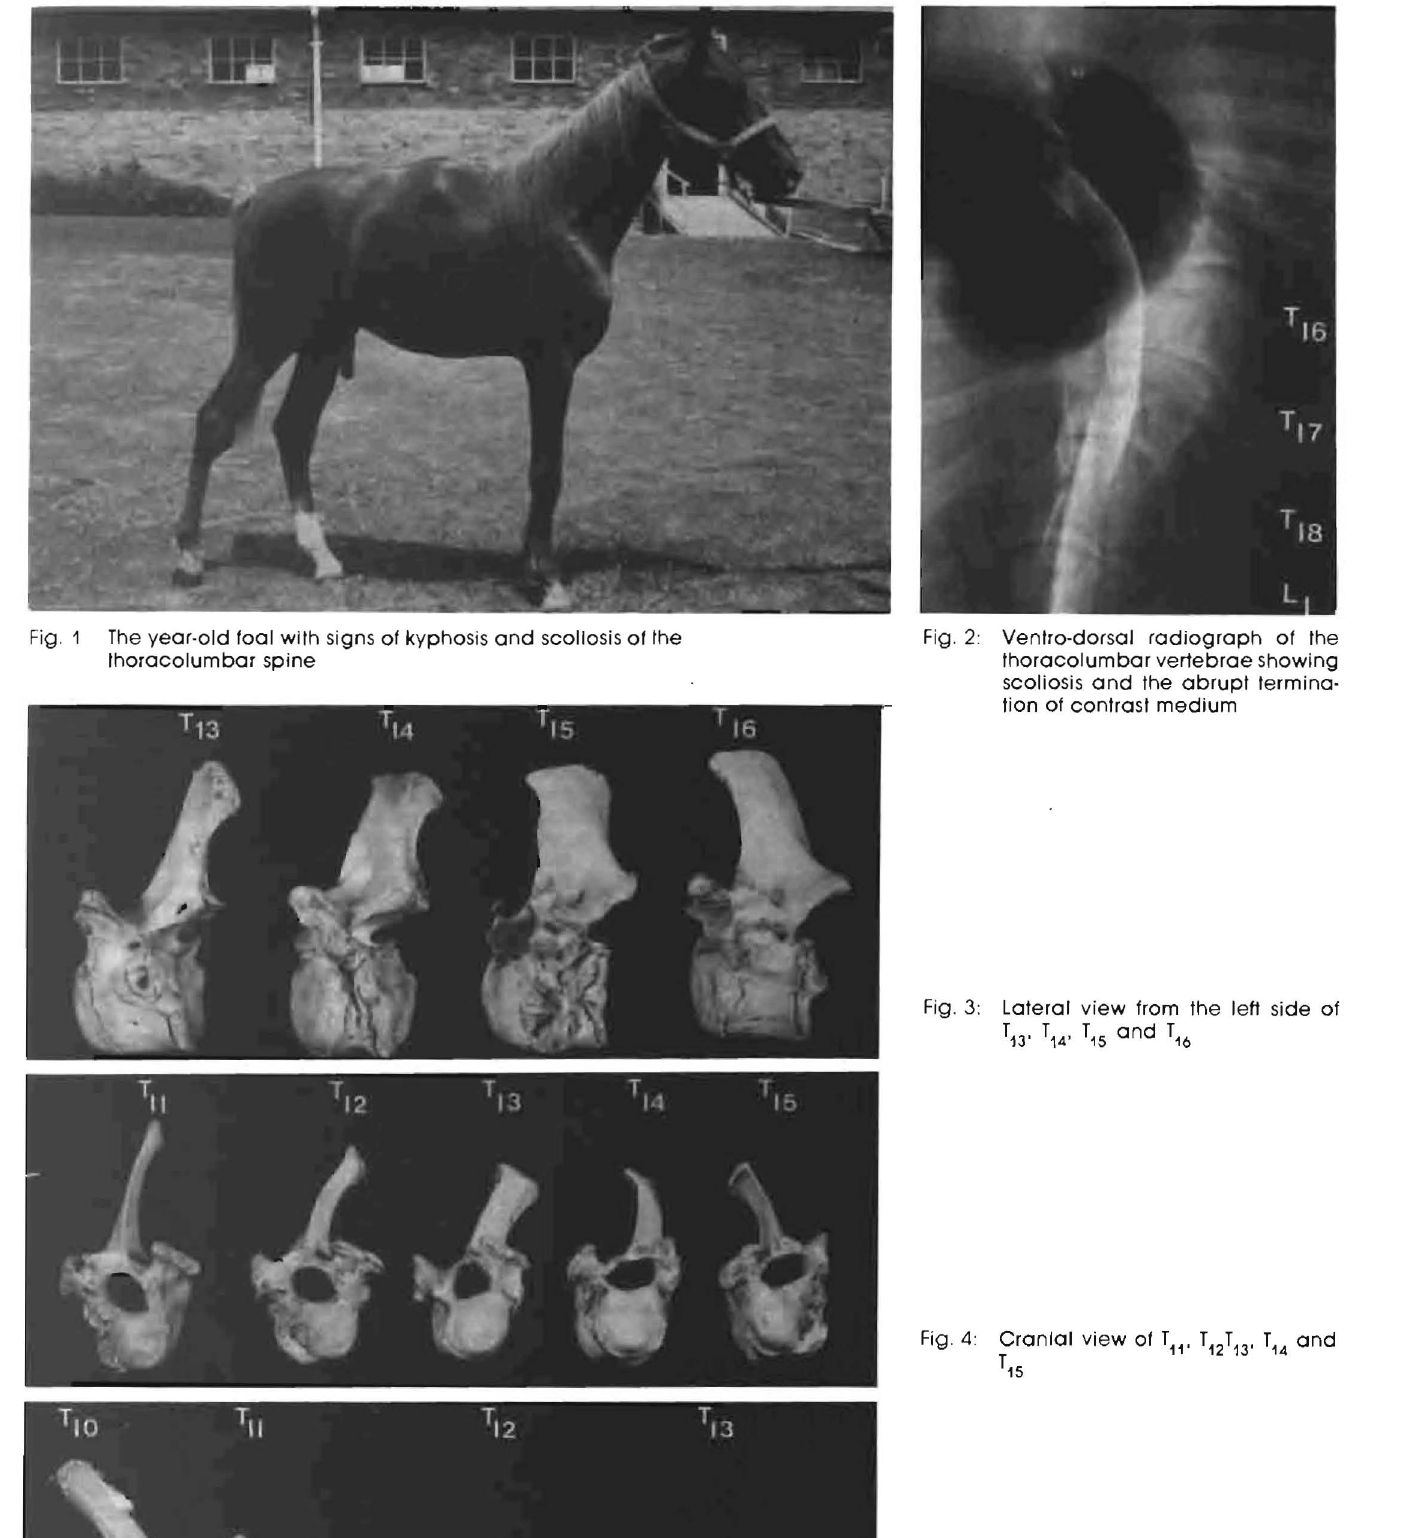
ll , T 12T 13, T14